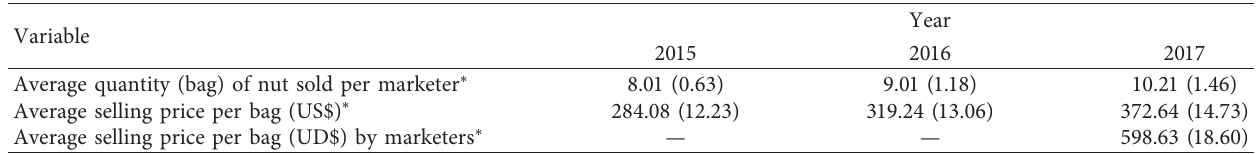
Table 14: Price and quantity of kola nuts sold,